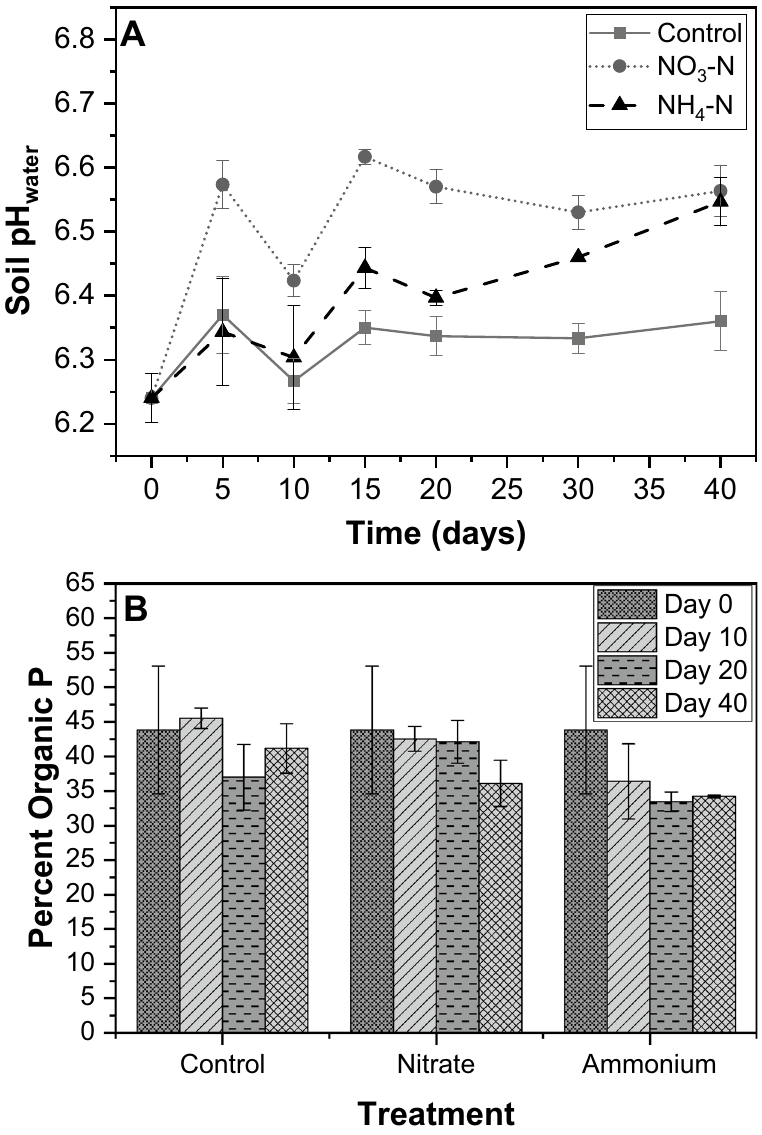
Figure 3. ( A ) Soil pH water over the course of 40-day incubation in the control and nitrate, and ammonium treatments (3.5 mg N kg −1 ). All analyses were conducted in triplicate. The error bars indicate the standard deviation. ( B ) Percent organic P on days 0, 10, 20, and 40 in the control and nitrate and ammonium treatments (3.5 mg N kg −1 ). All analyses were conducted in triplicate. The error bars indicate the standard